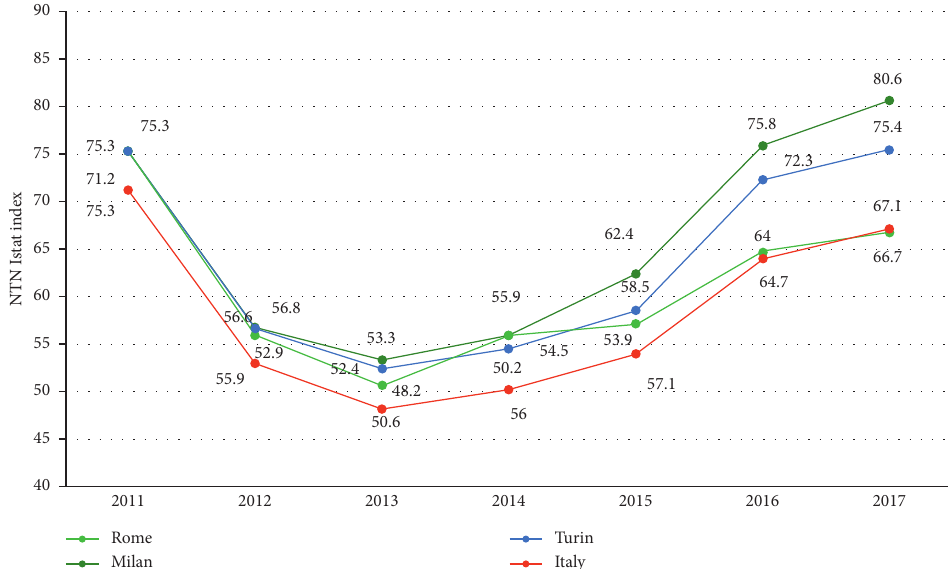
Figure 1: Index of the Normalized Transactions Number (NTN) in the principal Italian cities (source: authors’ elaboration on OMI-Agenzia delle Entrate